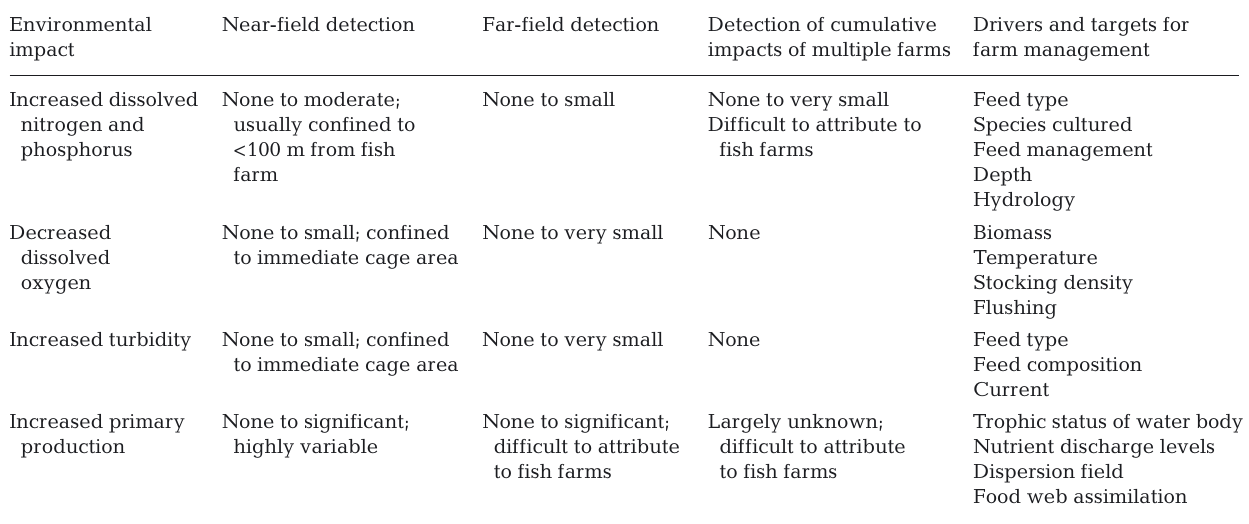
Table 6. Summary of environmental impacts of marine fish farms on water quality parameters at multiple